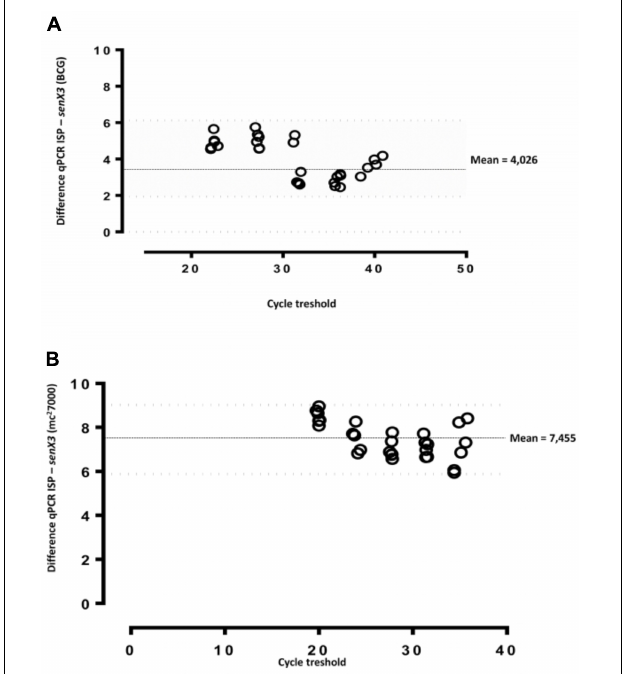
FIGURE 4 | Bland–Altman bias plots for two different quantitative MTBC DNA real-time PCR assays. Five serial dilutions of M. bovis BCG (A) and M. tuberculosis mc 2 7000 (B) strain were tested for MTBC DNA quantification by IS6110 and senX3 PCR assays. The mean bias was determined to be 4.026 and 7.455-cycle threshold for M. bovis BCG and M. tuberculosis mc 2 7000, respectively.